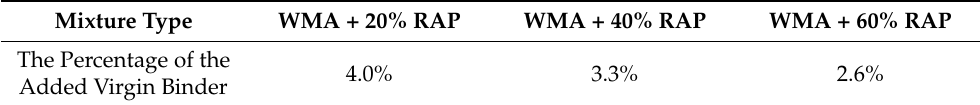
Table 18. Percentages of the virgin binder in the recycled WMA mixtures.